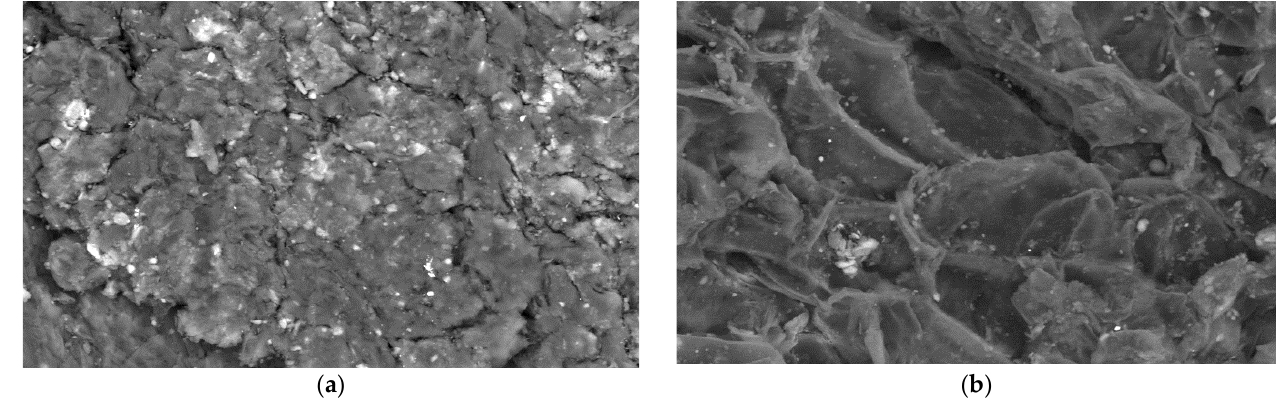
Figure 2. SEM micrographs of YP ( a ) before and ( b ) after Cr (VI) adsorption with magnification of ×500. Table 3. EDS composition